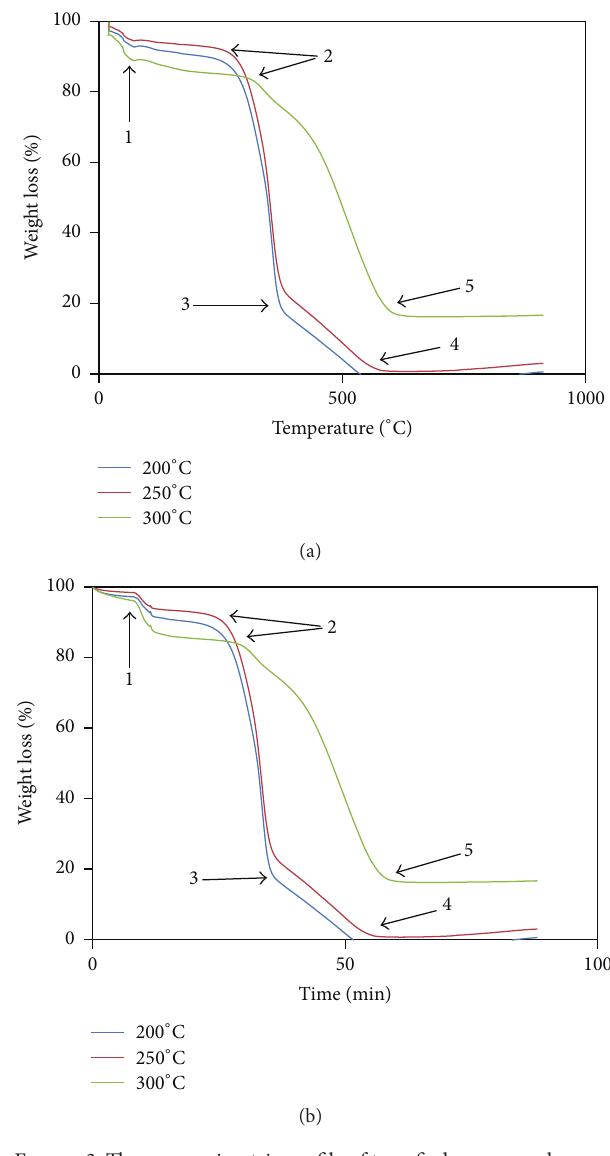
Figure 3: Thermogravimetric profile of torrefied sugarcane bagasse obtained for different torrefaction temperatures with (a) weight loss versus temperature and (b) weight loss versus